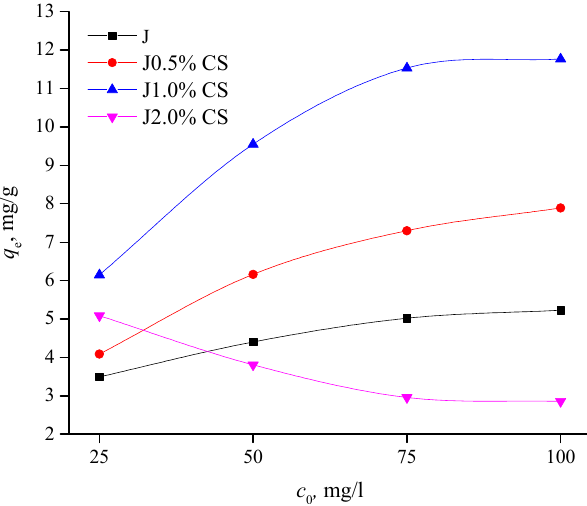
Figure 8. The effect of initial RO 16 concentration ( c 0 ) on the adsorption potential ( q ) of raw and chitosan-treated fabrics ( c 0 = 25, 50, 75, or 100 mg/L, t = 21 h, T = 25 °C, pH of 2.0 (for J, J0.5% CS, and J1.0% CS) and 4.0 (for J2.0% CS), the mass of adsorbent 0.25 g).